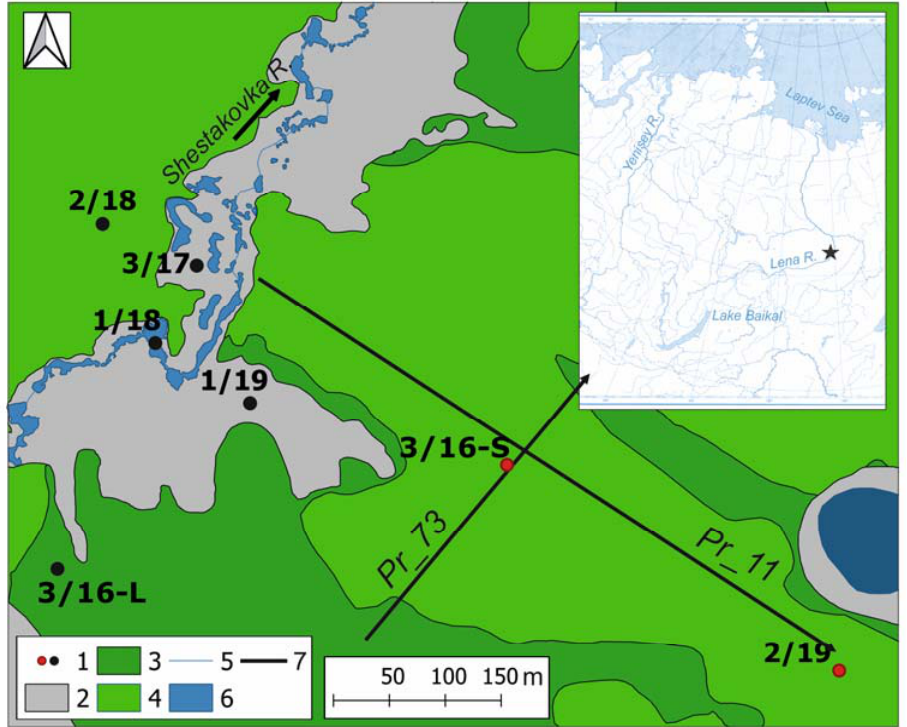
Figure 1. Scheme of the study site: 1—boreholes, red circles in talik, black circles in permafrost from the surface, 2—moss-grass bogs, 3—larch and birch forest, 4—pine forest, 5—river, 6—water body, 7—GPR profiles.